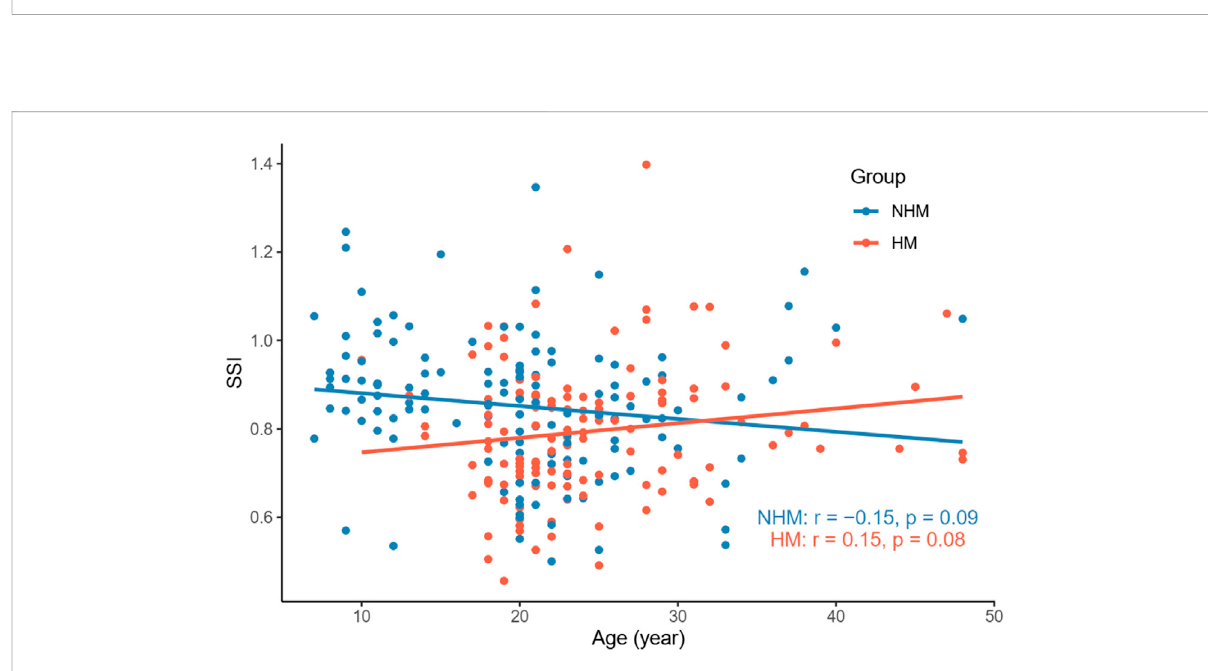
FIGURE 4 Relationship between age and SSI in the two groups. We did not fi nd a signi fi cant correlation between age and SSI in the NHM ( r = -0.15, p = 0.09) or HM ( r = 0.15, p = 0.08) group. Abbreviation: NHM, non-high myopia; HM, high myopia; SSI, stress – strain